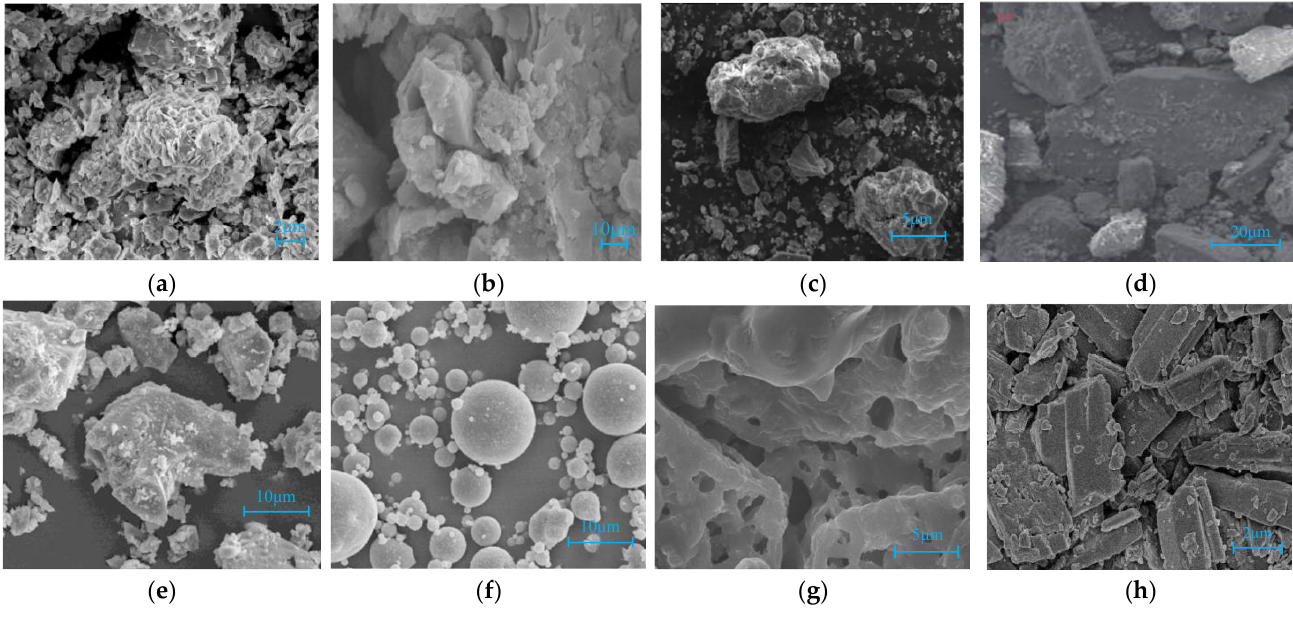
Figure 9. SEM images of the cemented backfill material [37,47 – 50]: ( a ) coal gangue magnified by 5000×; ( b ) limestone magnified by 4000×; ( c ) tailings magnified by 5000 ×; ( d ) river sand magnified by 4000×; ( e ) magnified Portland cement; ( f ) magnified coal ash; ( g ) magnified lime; ( h ) magnified gypsum.